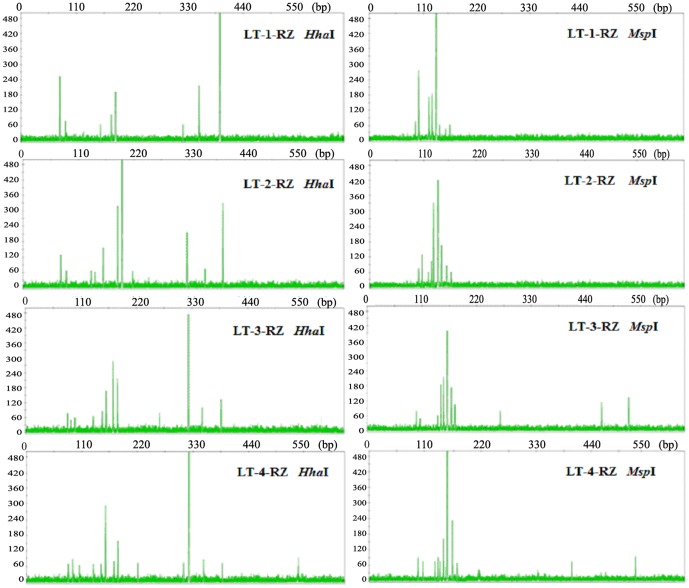
T-RFLP profiles for the rhizomes of Alpinia officinarum Hance plants at various ages.The profiles were produced via either HhaI or MspI mono-digestion T-RFLP method targeting amplified fungal rDNA ITS sequences from the rhizomes of 1- to 4-year-old A. officinarum Hance planted at site LT. The T-RFLP analysis was repeated in three independent samples for each year, and the representative T-RFLP profiles are shown.